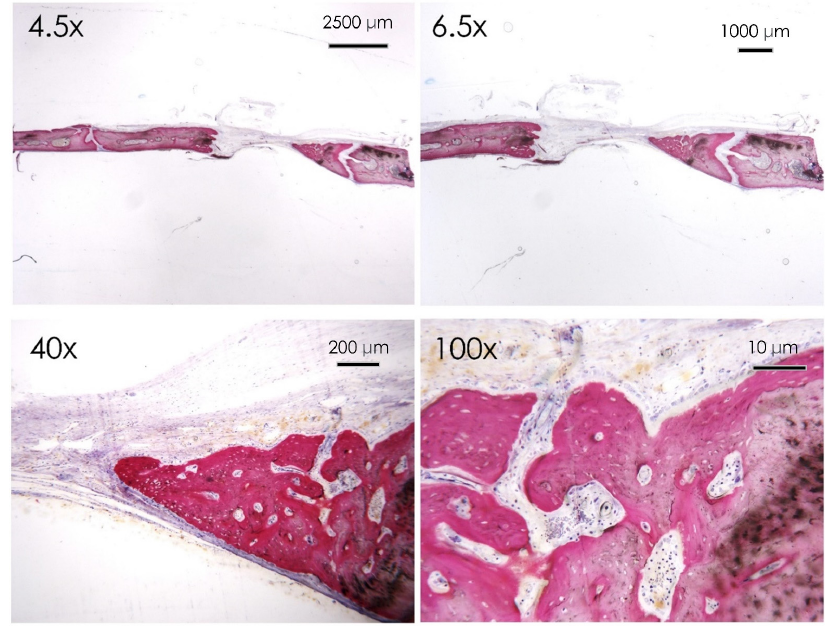
Figure 9. Resveratrol group. Histological section of the calvaria bone specimens at different magnifications (4.5×, 6.5×, 40×, and 100×). A filling of the bone defect was reported after 30 days of resveratrol administration.